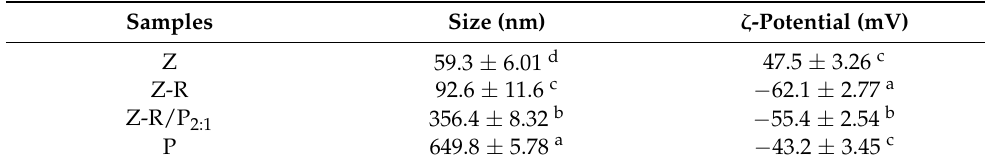
Values are means ± SD (n = 3). Different letters within the same column are statistically different ( p < 0.05).